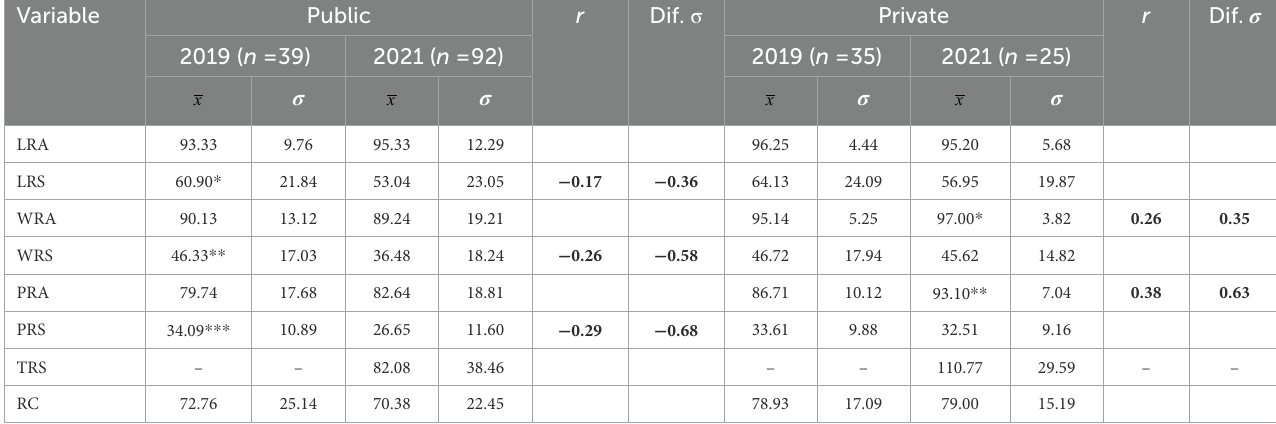
TABLE 5 Averages and pre-post pandemic differences in fourth grade (public vs. private). Variable